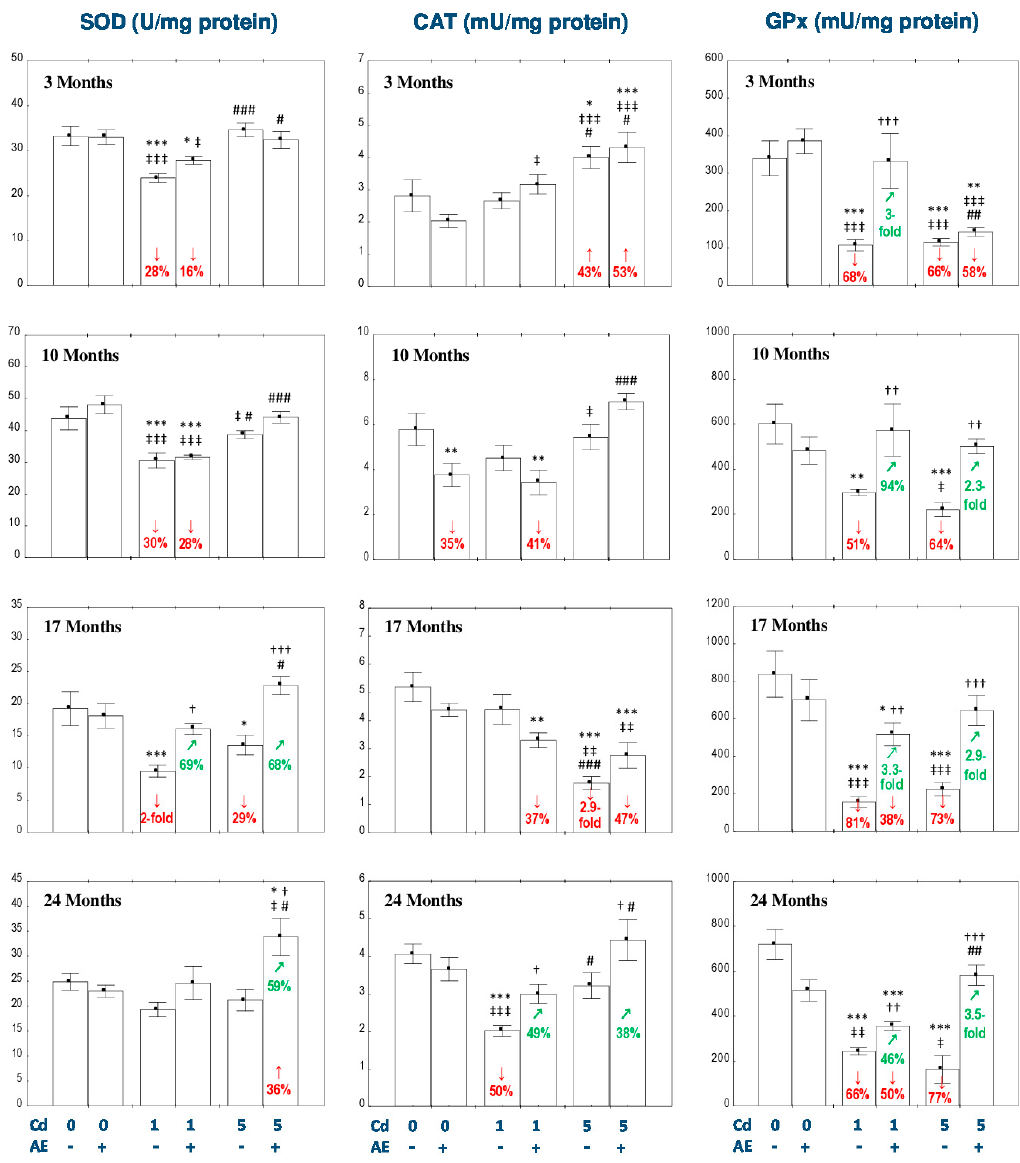
Figure 1. The effect of the extract from the berries of Aronia melanocarpa L. (AE) on the activities of superoxide dismutase (SOD), catalase (CAT), and glutathione peroxidase (GPx) in the liver of rats exposed to cadmium (Cd). The rats received Cd in the diet at the concentration of 0, 1, and 5 mg Cd/kg and/or 0.1% aqueous AE (+) or not (-). Data are presented as mean ± SE for 8 rats, except for seven animals in the AE, Cd 1 , and Cd 5 group after 24 months. Statistically significant differences (ANOVA, Duncan’s multiple range test): * p < 0.05, ** p < 0.01, *** p < 0.001 vs. control group; † p < 0.05, †† p < 0.01, ††† p < 0.001 vs. respective group intoxicated with Cd alone; ‡ p < 0.05, ‡‡ p < 0.01, ‡‡‡ p < 0.001 vs. group receiving AE alone; # p < 0.05, ## p < 0.01, ### p < 0.001 vs. respective group receiving the 1 mg Cd/kg diet (alone or with AE). Numerical values in bars disclose the percentage changes or factors of changes in comparison to the control group ( ↓ , decrease; ↑ , increase) or the respective group receiving Cd alone ( ↗ , increase).